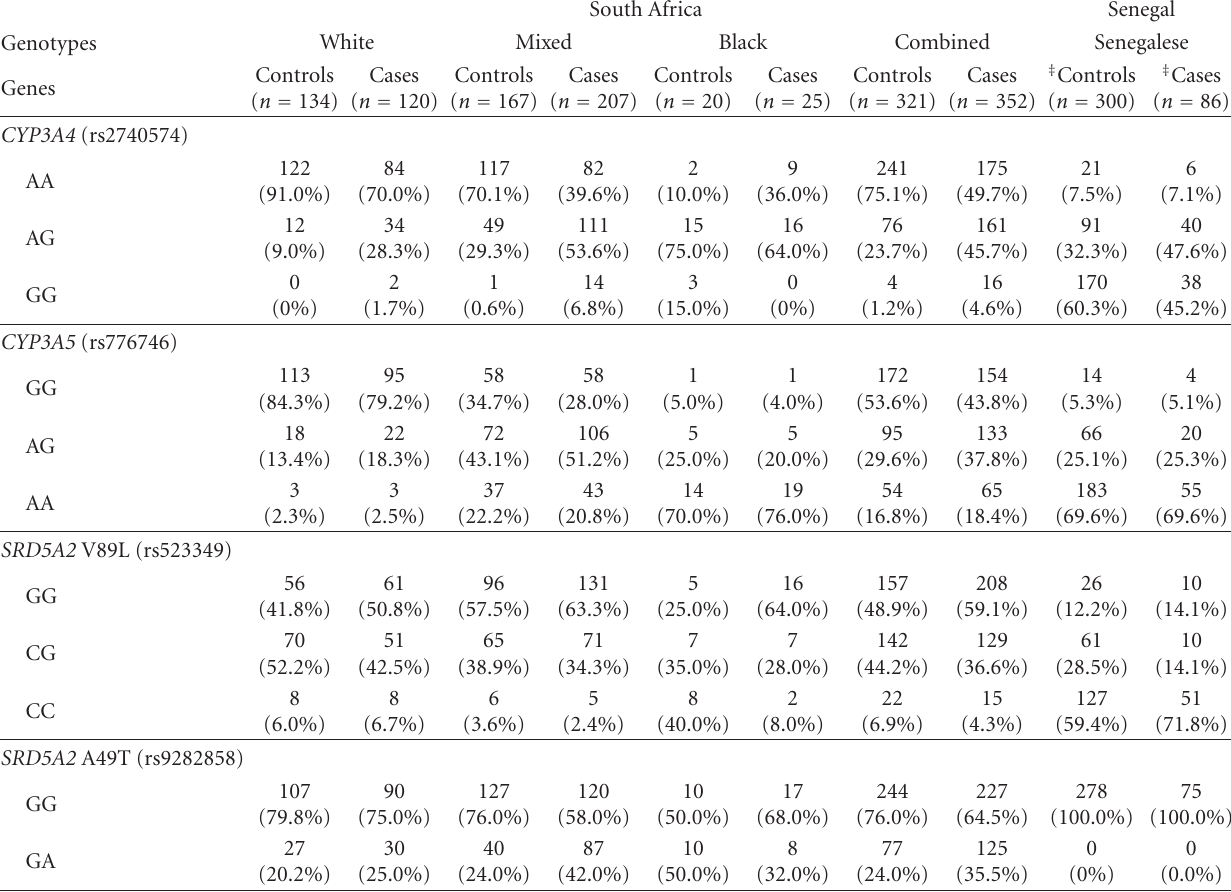
Table 2: Frequency of genotypes among South African and Senegalese prostate cancer cases and controls.